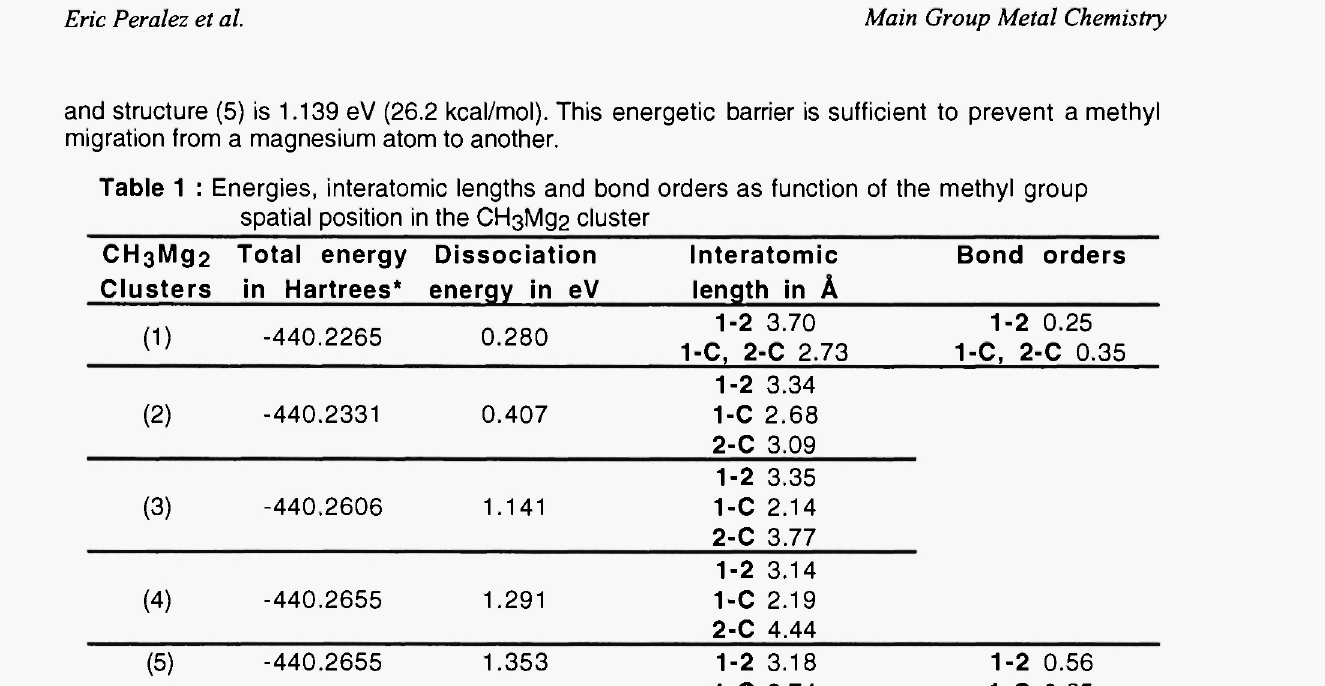
Table 1 : Energies, interatomic lengths and bond orders as function of the methyl group spatial position in the CH3Mg2 cluster Total energy Dissociation Interatomic Bond orders Clusters in Hartrees* energy in eV length in Ä